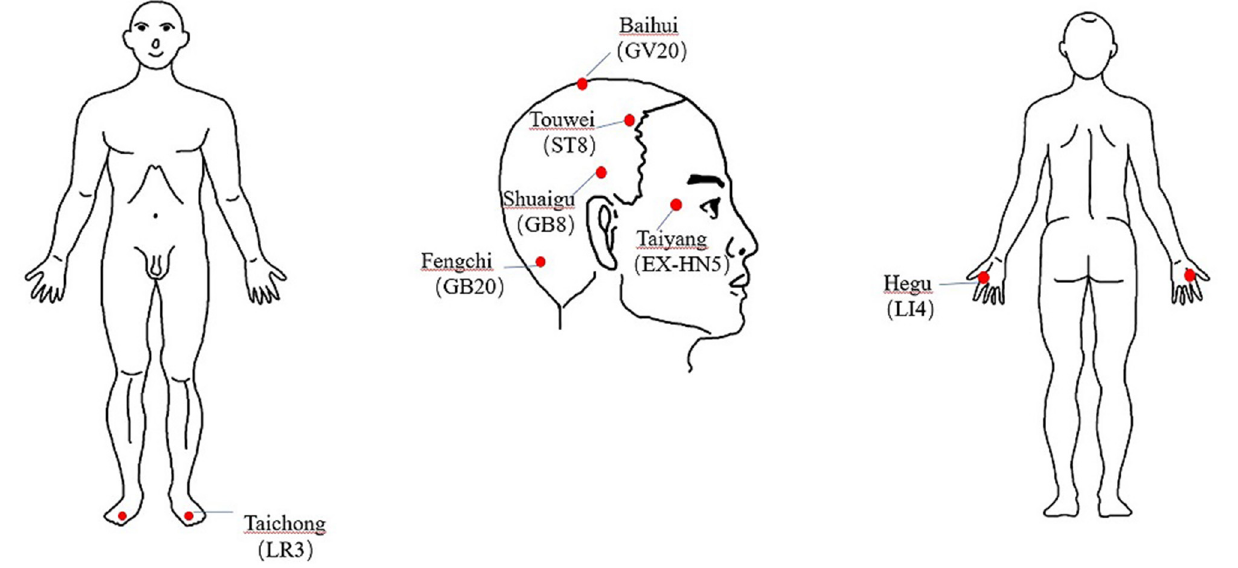
FIGURE 2 | Indication of acupoints location of the acupuncture prescription in this study. The name, English code and location of each acupoint is in accordance with WHO Standard Acupuncture Point Locations in the Western Pacific Region. Retaining needles for 60 mins. Lifting, thrusting, twisting and/or rotating the needles once every 20 mins with intermittent stimulation for maintaining the deqi sensation for twice. EX-HN, Extrachannel points; GB, Gallbladder Meridian; GV, Governor Vessel; LI, Large Intestine Meridian; LR, Liver Meridian; ST, Stomach Meridian. severe pain, according to the evidence-based clinical practice guidelines (Scottish Intercollegiate Guidelines Network,